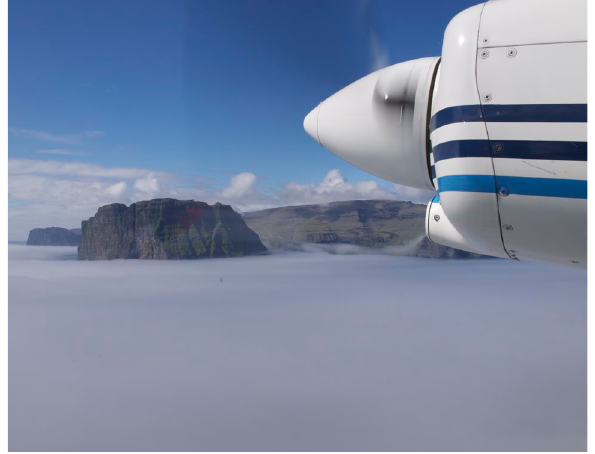
Figure 5. Foggy conditions during the aerial survey in the Faroe Islands (Photo by Helena